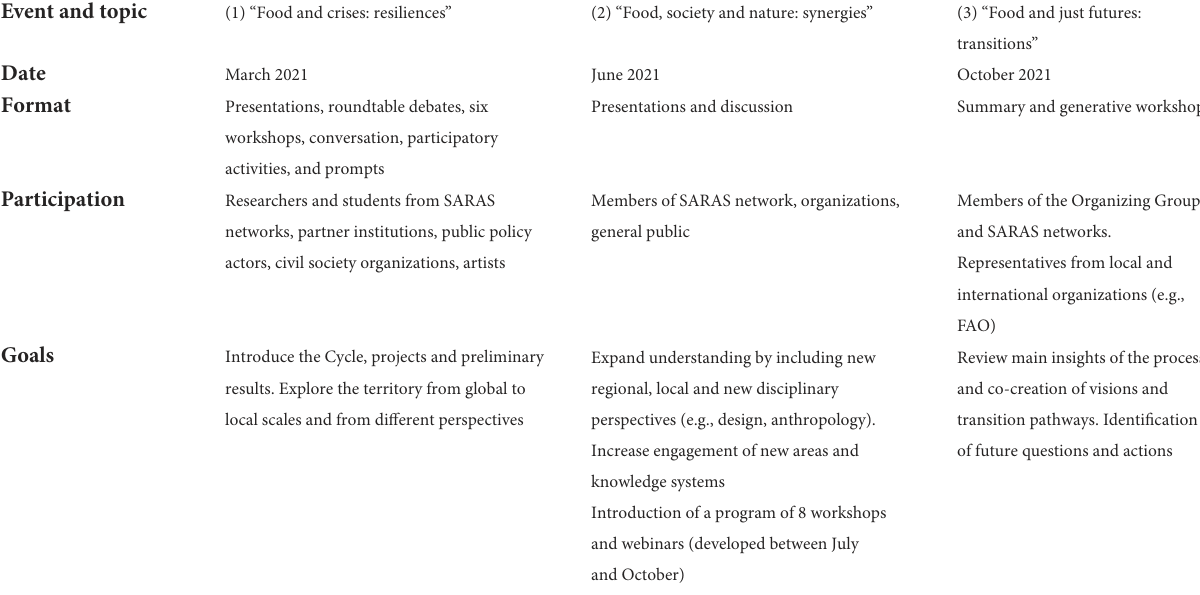
TABLE 4 Overview of virtual events during the third public phase: “Knowledges on the table: toward sustainable food systems and practices.”